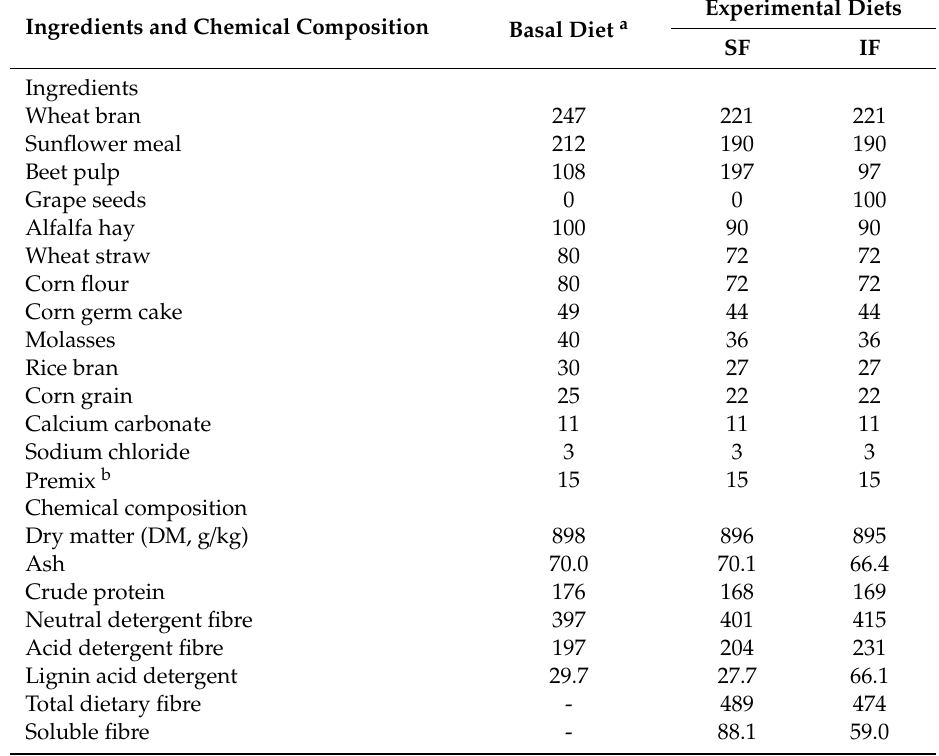
Table 1. Ingredients (g / kg) and chemical composition (g / kg DM) of the